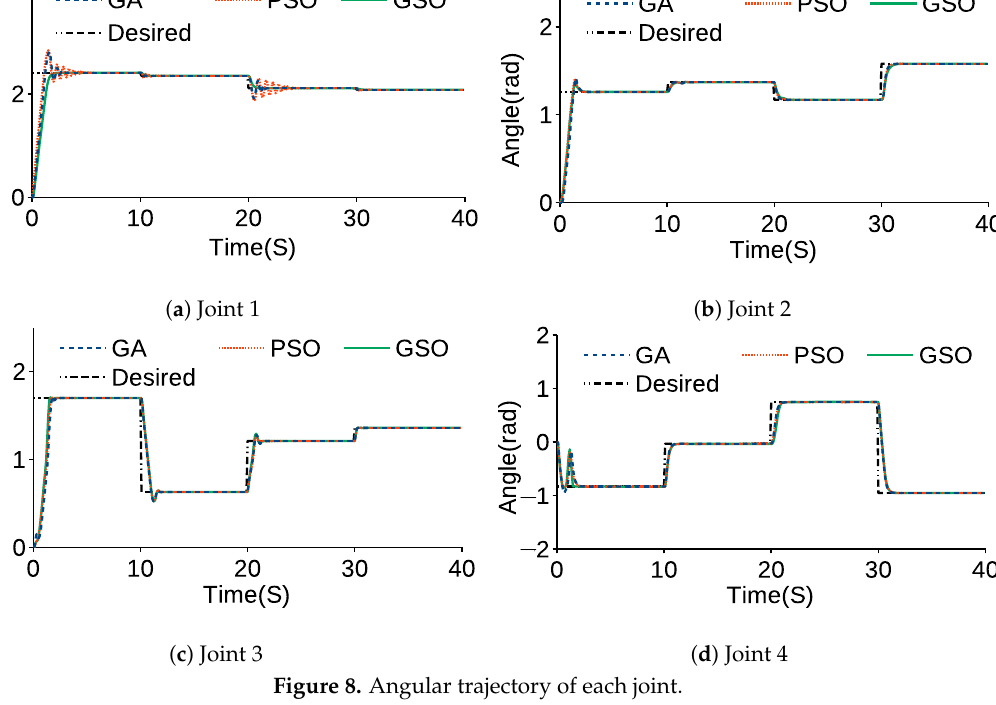
Figure 8. Angular trajectory of each joint.